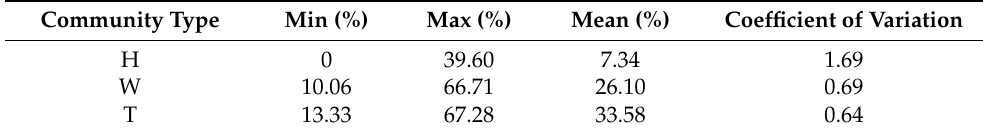
Table 2. The characteristics of vegetation